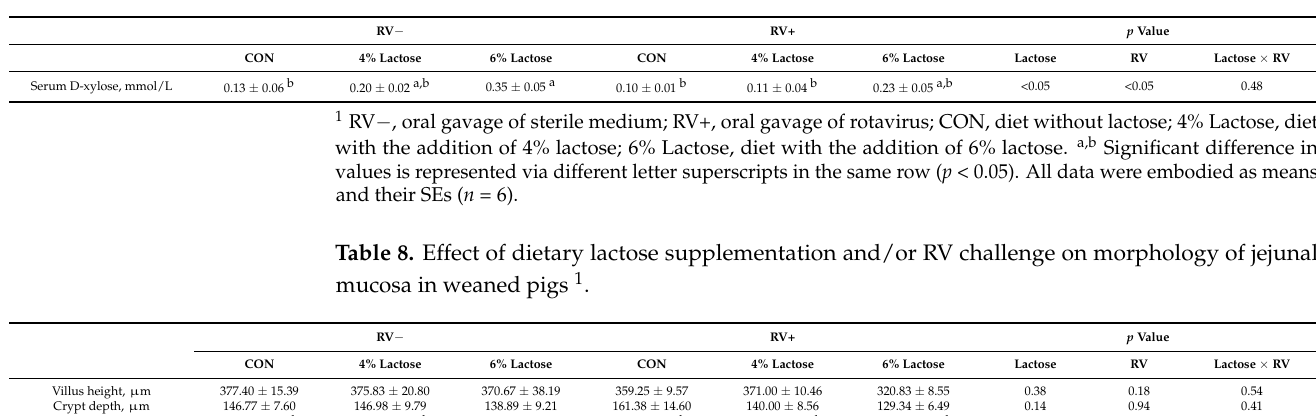
Table 7. Effect of dietary lactose supplementation and/or RV challenge on serum D-xylose concentra- tion in weaned pigs 1 .